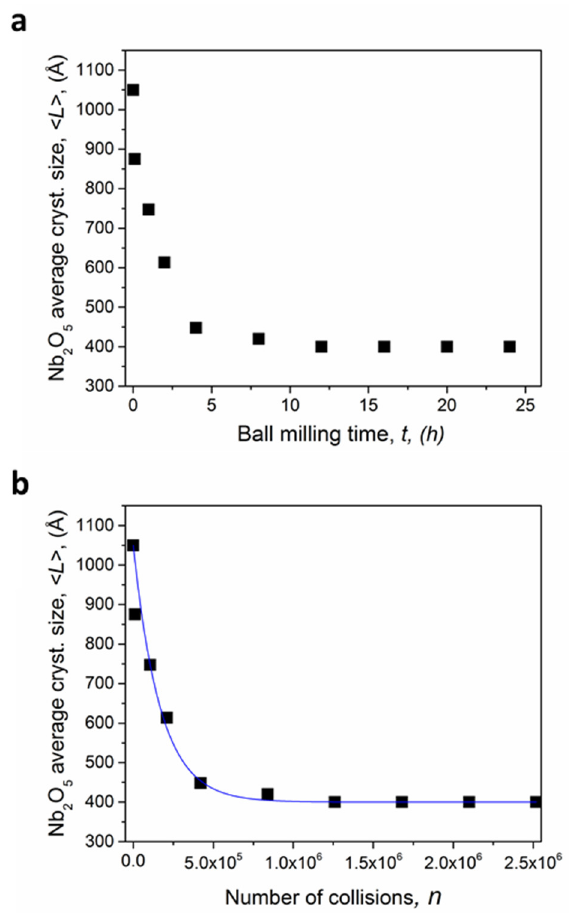
Figure 2. Average crystallite size <L> of coherent diffraction domains as a function of the milling time t m ( a ) and total number n of collisions ( b ).